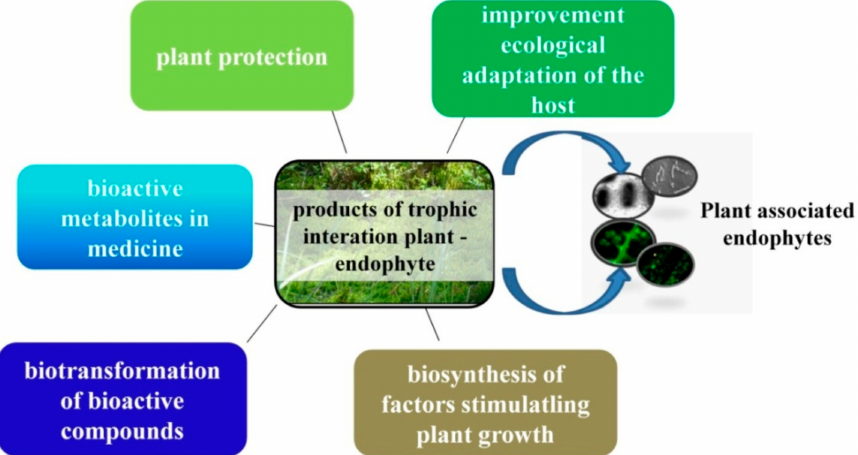
Figure 1. Usefulness of products resulting from trophic-plant interactions of endophytes in agriculture and biotechnology. Oval images present plant associated endophytes seen under the fluorescence and electron microscopes (photos taken by the